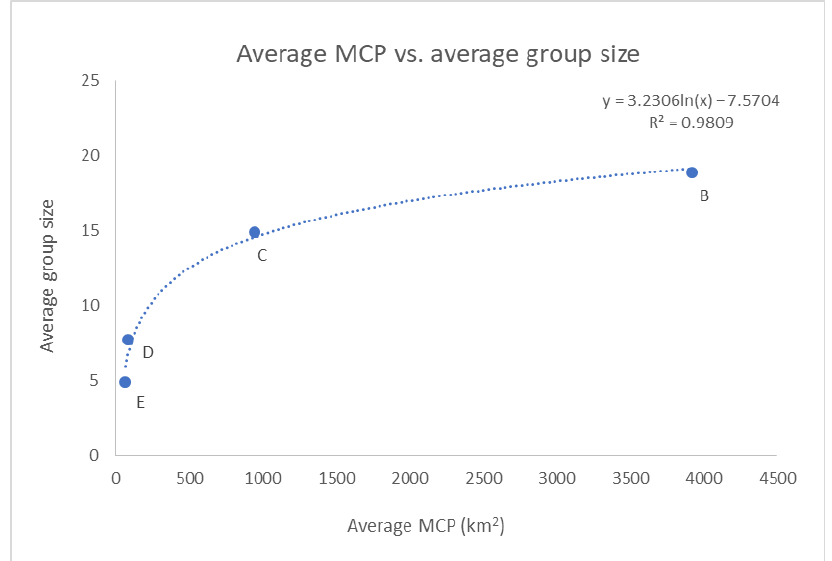
Figure 13. The correlation between the average MCP and the average group size across the clusters resulted statistically significant ( p -value < 0.01). Cluster A was excluded by the analysis as in Figure 12.